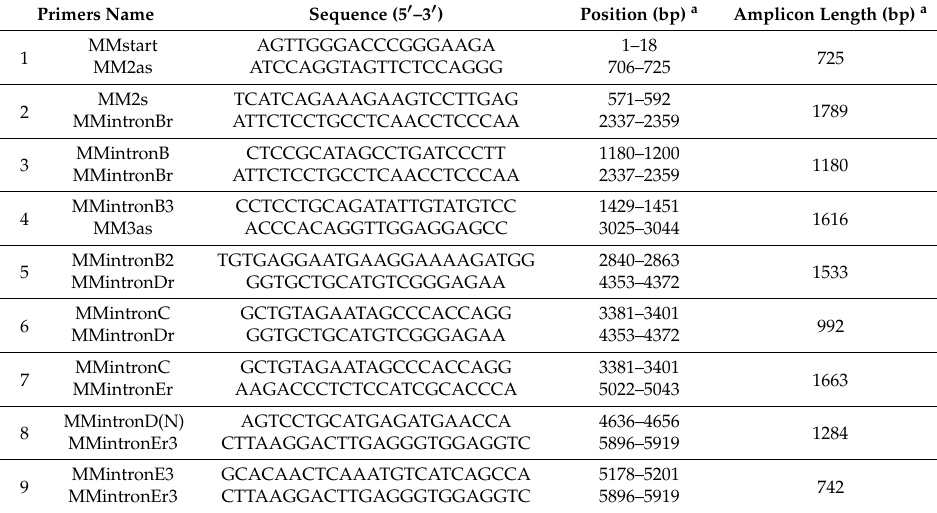
Table 8. Specific primers applied for identification of the human PAG-L genomic